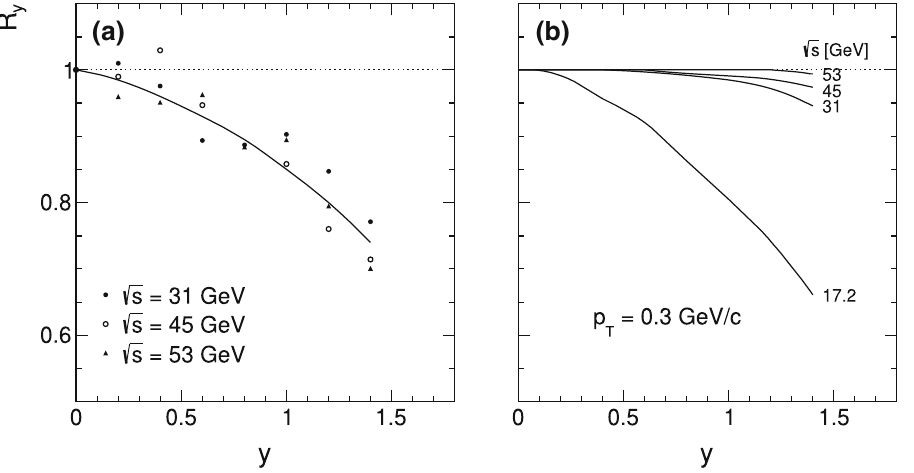
Fig. 36 a Ratio R y = f ( y )/ f ( 0 ) of the forward cross sections [19] to thecentralonesasafunctionofrapidity,averagedover p T ,forthreeISR energies between 31 and 53 GeV. The full line is given to guide the eye;